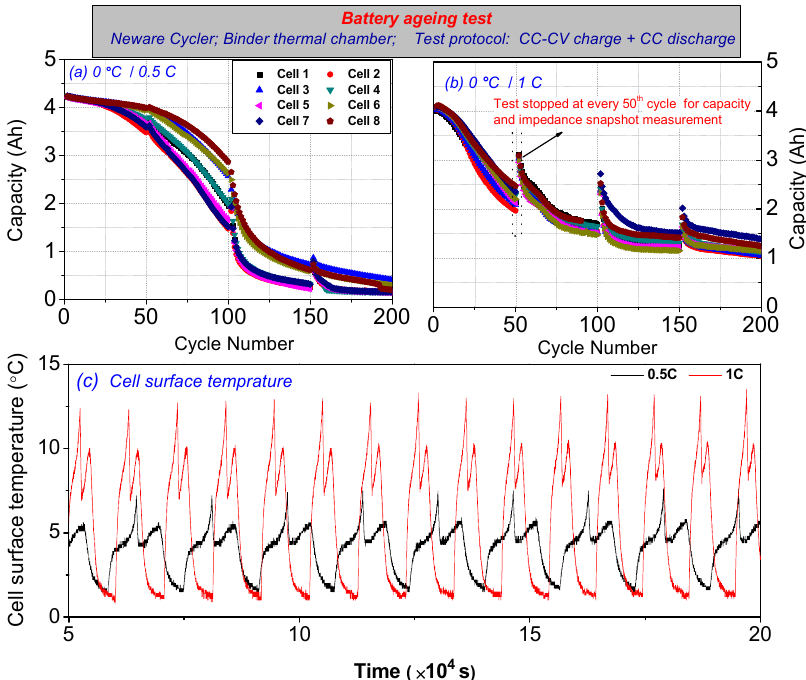
Figure 2. Battery status during 0 °C cyclings under a CC-CV charge and CC discharge test protocol. ( a ) Capacity cycled at 0.5 C; ( b ) capacity cycled at 1 C; ( c ) cell surface temperature.